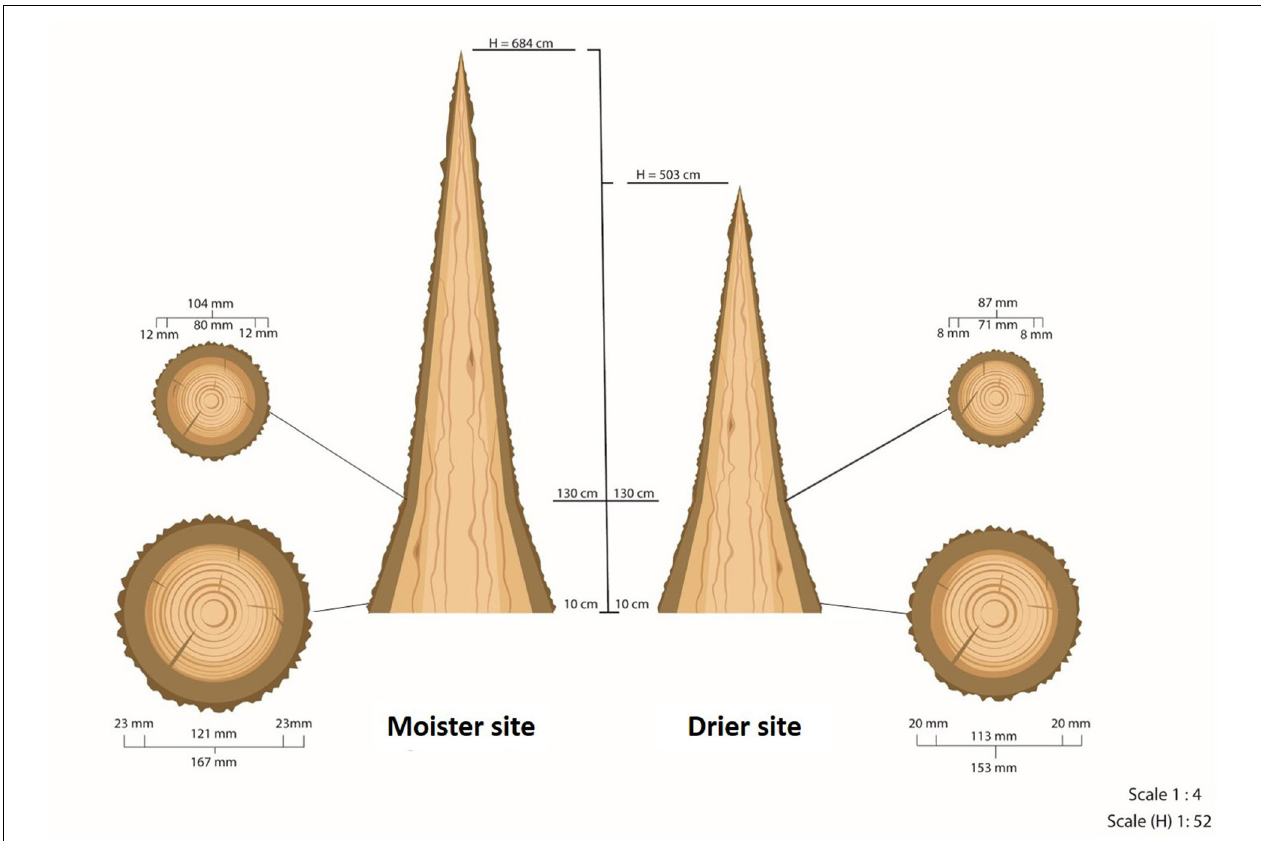
FIGURE 2 | Scheme of the average tree at each of the test sites. H is the total height of the tree. Diameters and bark thicknesses of the circular cross-sections were measured at 10 and at 130 cm from the ground. This scheme does not represent the real taper of wood and bark along the trunk above 130 cm due to the lack of measurements at higher heights. This taper is neither constant nor homogeneous.